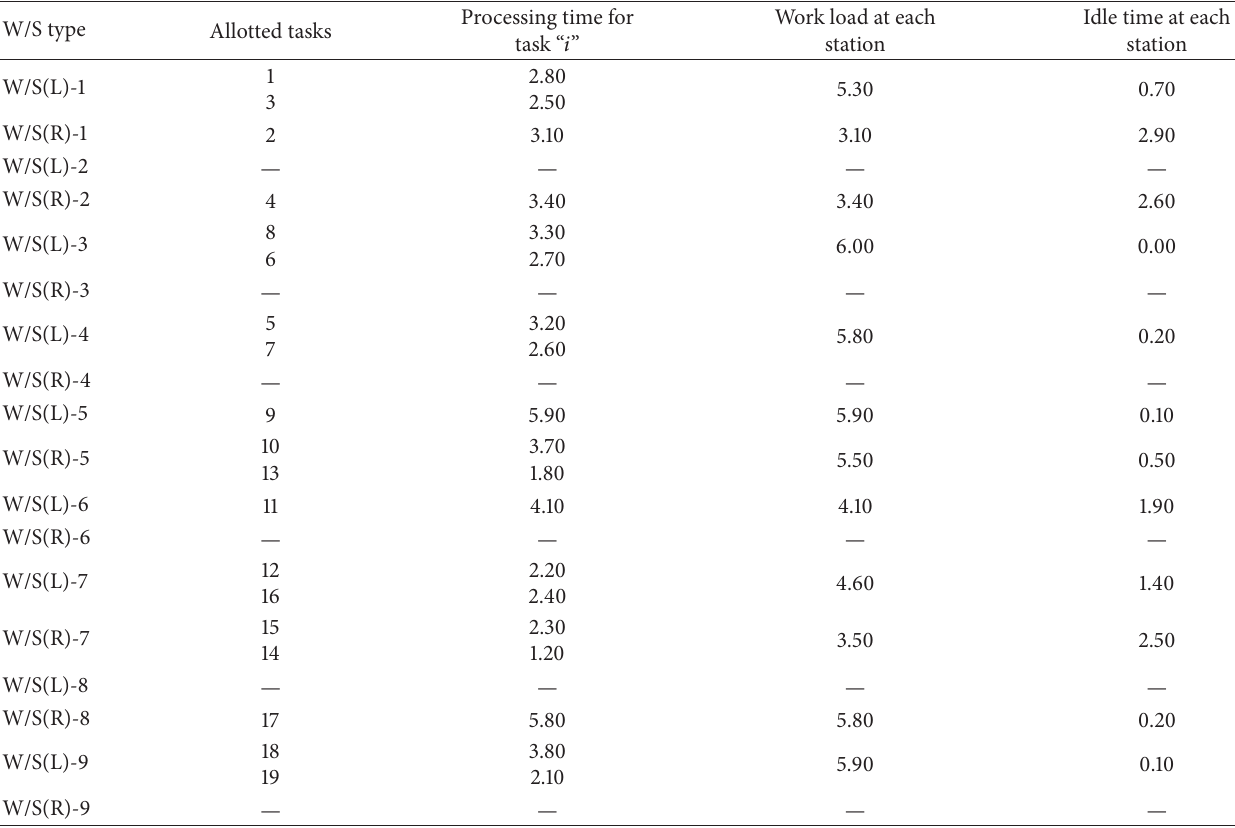
Table 6: Allocation of tasks for 9th assignment of P19 (CT =